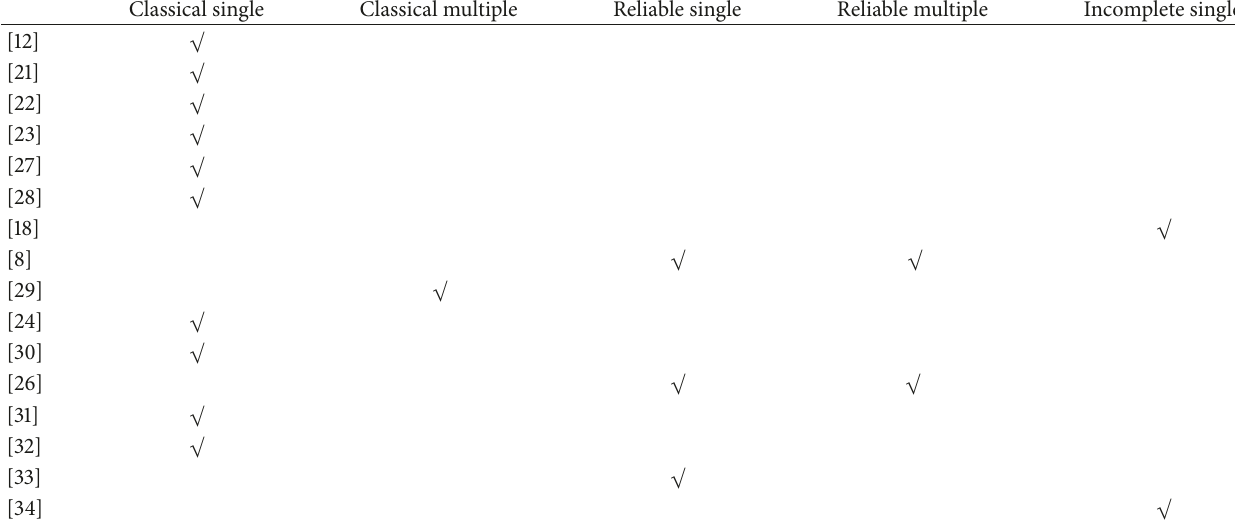
Table 1: Summary of different allocation problems in the